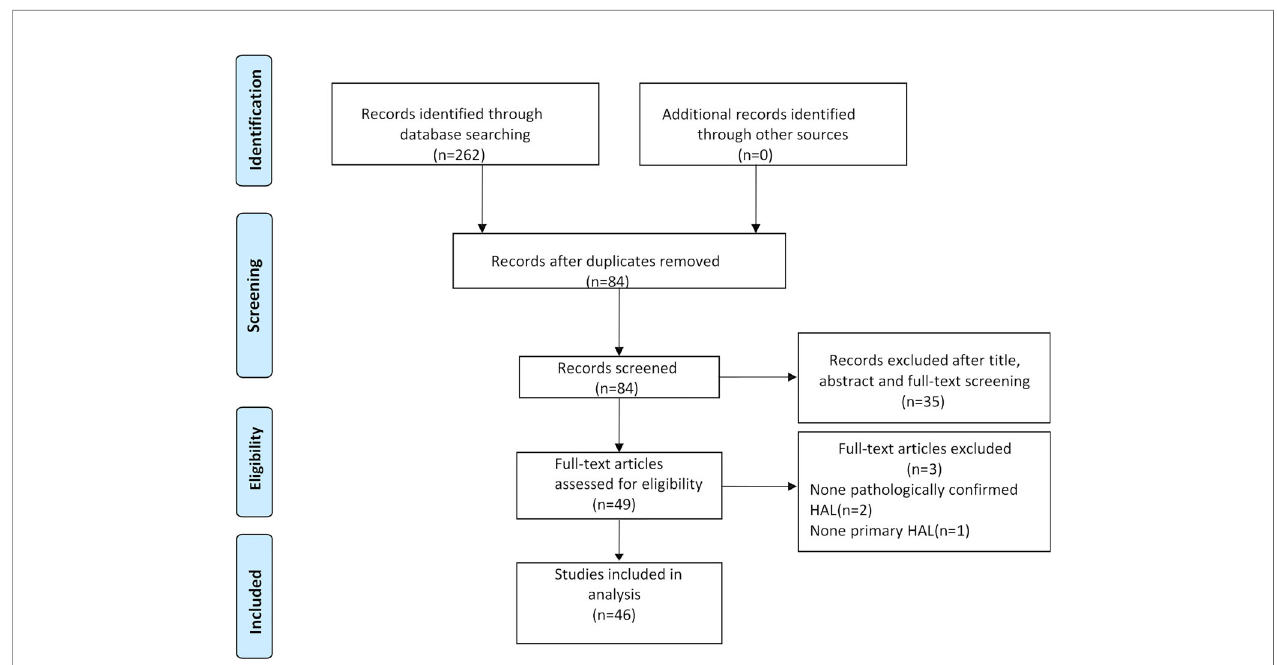
FIGURE 1 | Paper selection fl